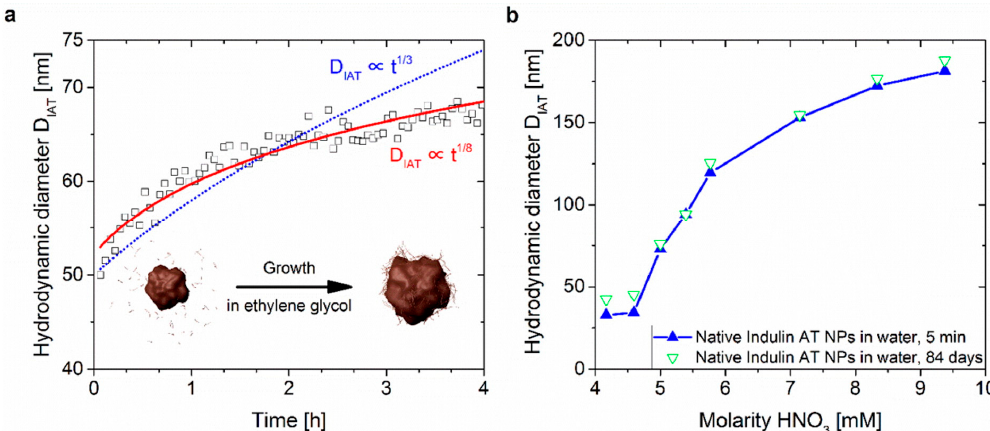
Figure 6. ( a ) Growth kinetics after the initial pH drop with a final HNO 3 concentration of 5 mM; ( b ) Hydrodynamic diameter versus final concentration of HNO 3 after the pH drop. Reprinted with permission from Richter et al. [43]. Copyright 2016 American Chemical Society.